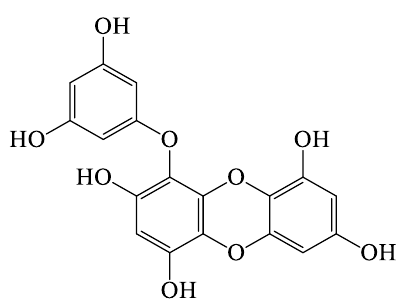
Figure 1. Chemical structure of eckol isolated from E. cava.